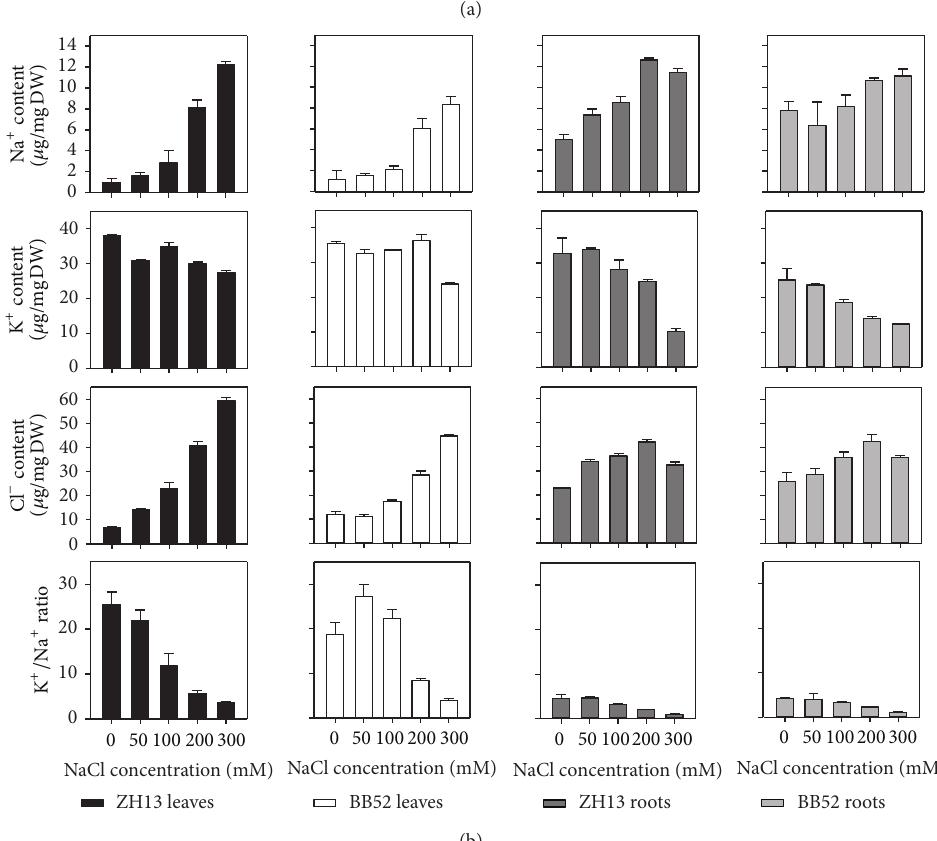
Figure 3: (a) Changes of ion content in young seeding under salt stress. (b) Changes of ion content in mature seeding under salt